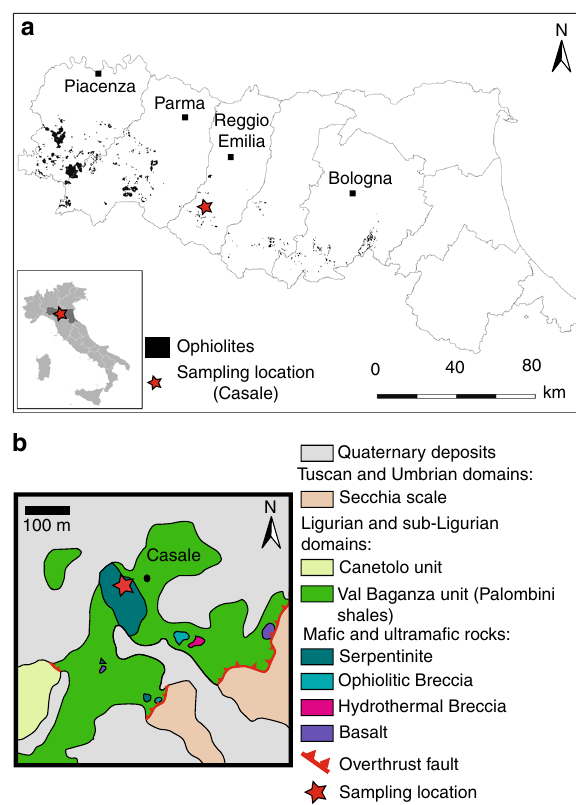
Fig. 1 Sampling location and geological maps. a General map of the ophiolite outcrops in Emilia-Romagna (Italy) and sampling location (red star) modi fi ed from ref. 54 . b Geological map of the sampling location, modi fi ed from ref.